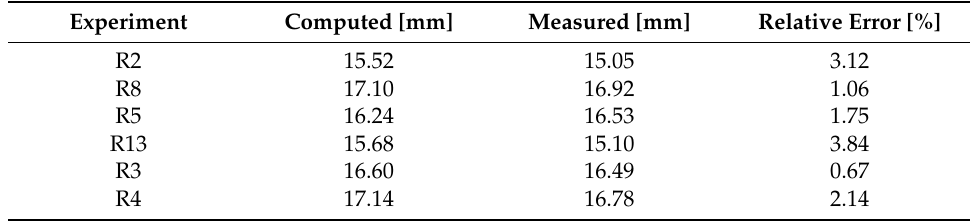
Table 5. A comparison between the predicted and observed neutral radius location for different temperatures, loading rates, and friction conditions.